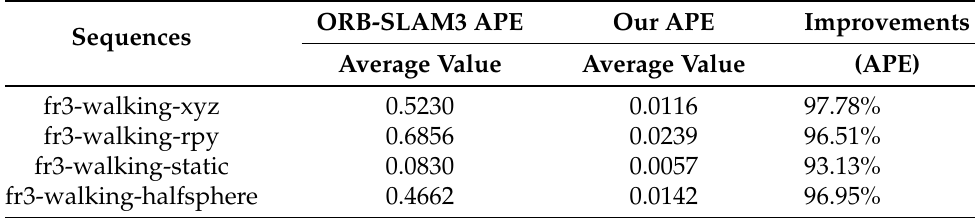
Table 4. Percentage of average APE reduction.